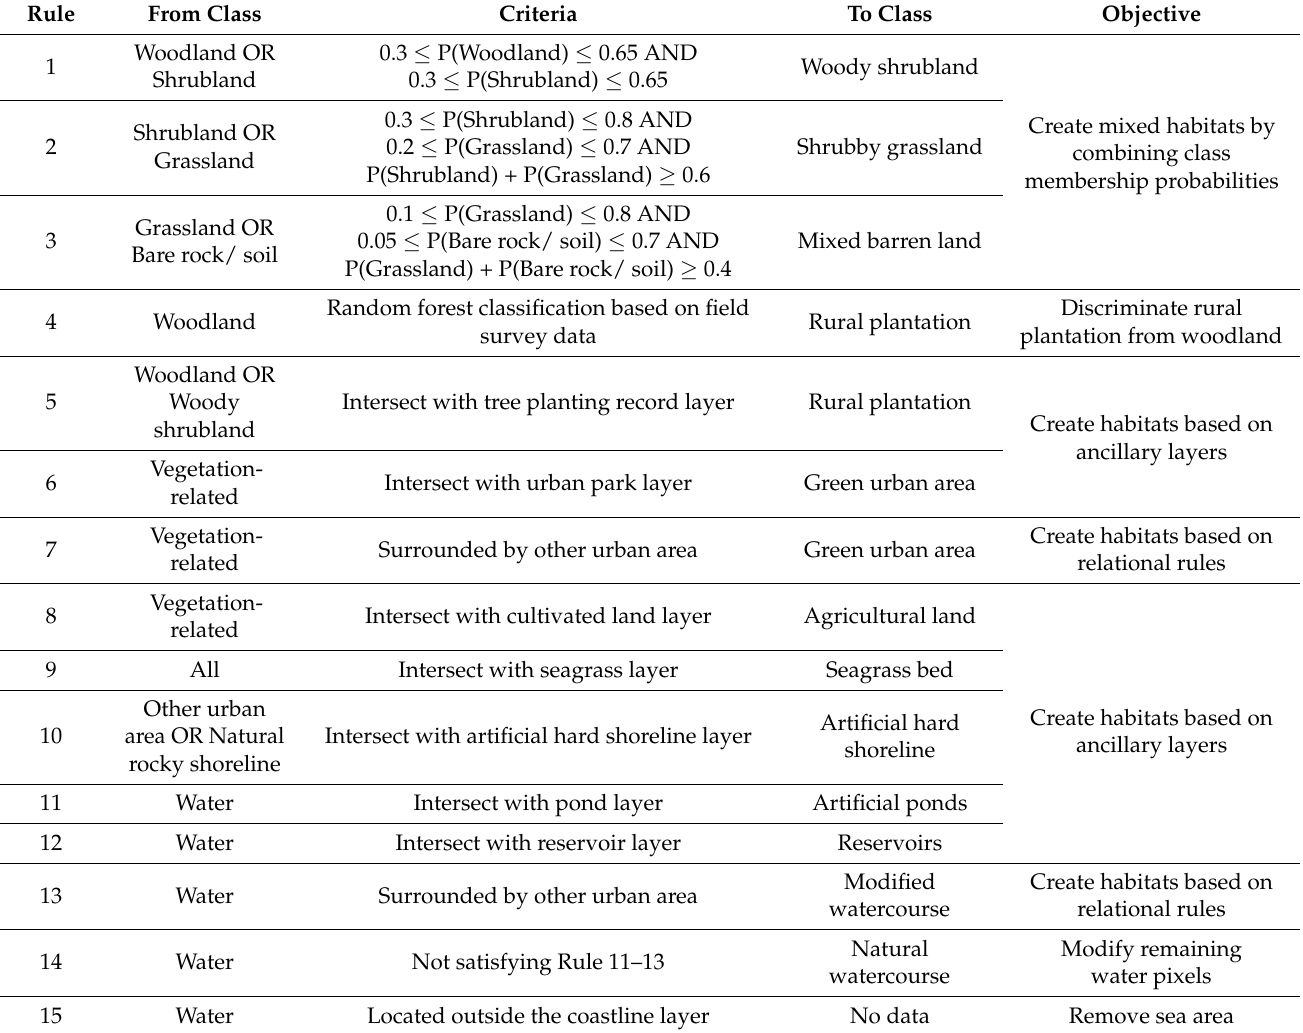
Table 7. Modification rules used in stage 3 to expand from 10 to 21 habitat